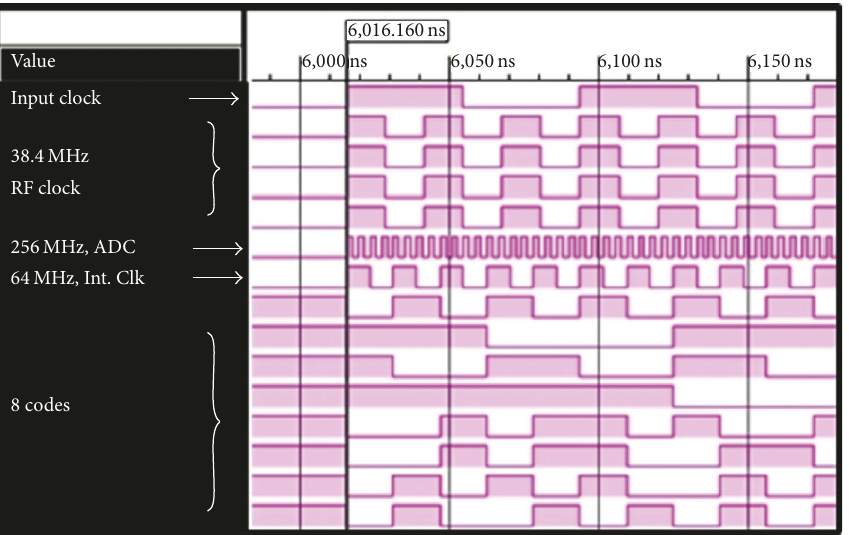
Figure 3: Simulated signal waveforms as required by the 8-channel OSCR system.